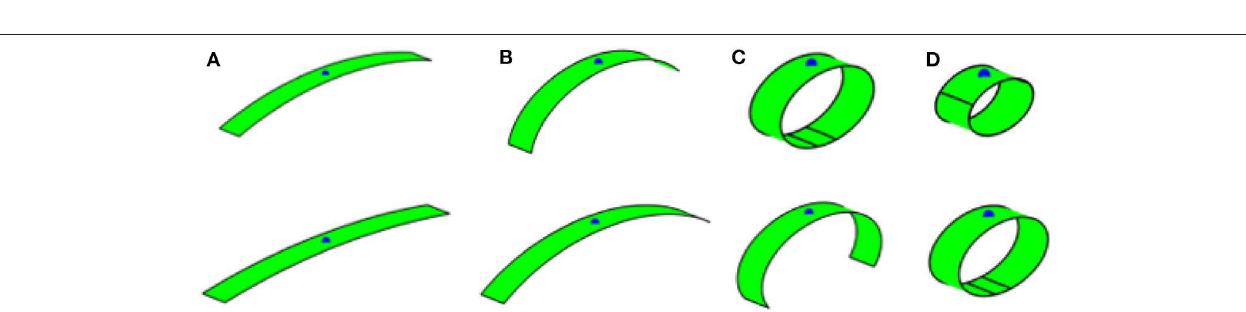
FIGURE 9 | Folding of 50 × 5rectangular plate, m 1 = 0. Top: with poisson’s effect; bottom: without poisson’s effect. (A) Electric field 25 MV/m; (B) electric field 43 MV/m; (C) electric field 68 MV/m; and (D) electric field 86 MV/m.